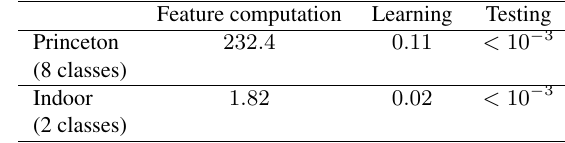
Figure 5: Indoor objects. We acquired 20 indoor objects with a Leica Scanstation P20 laser scanner. The sampling of the objects is heterogeneous and partly suffers from anisotropy. The lower 10 objects are labeled as chairs whereas the upper ten objects are labeled as non chairs.